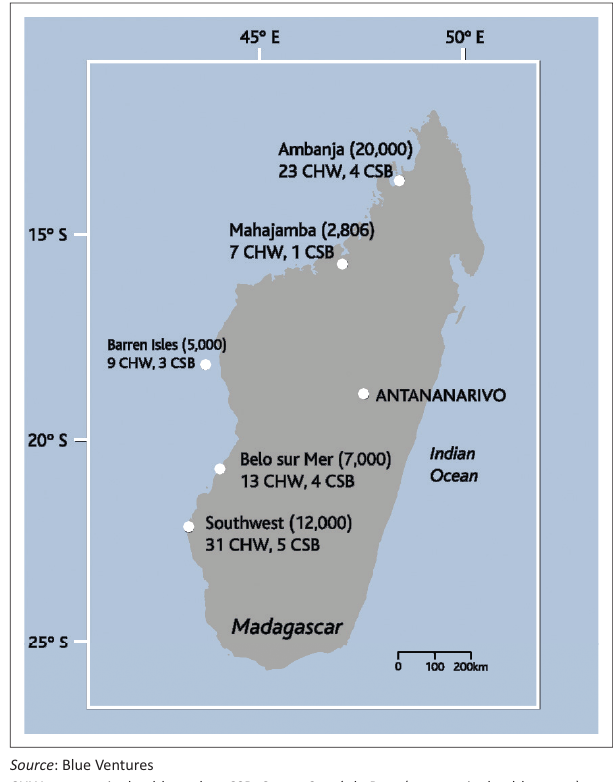
FIGURE 1: The zones where Blue Ventures operates in Madagascar and the number of community members (in parentheses), community health workers and community health centres supported at each